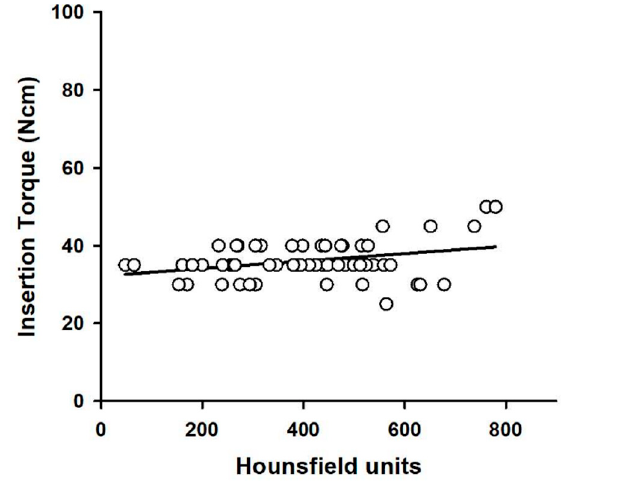
Figure 1. Three-dimensional images of implants showing bone types and corresponding Houns- field units, generated by OnDemand ® software (Cybermed, Seoul, Korea): ( a ) CMI implant and ( b ) SLActive implant.